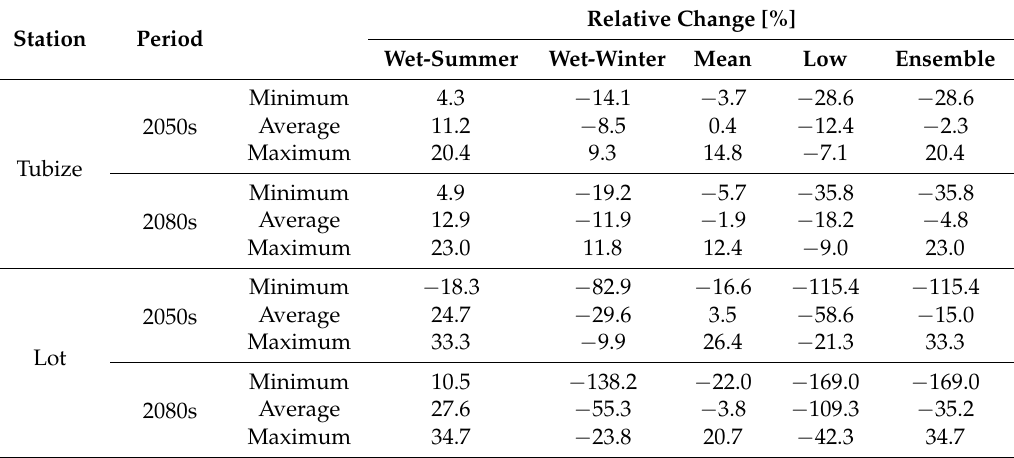
Table 3. Minimum, average, and maximum changes in extreme low flows relative to the control